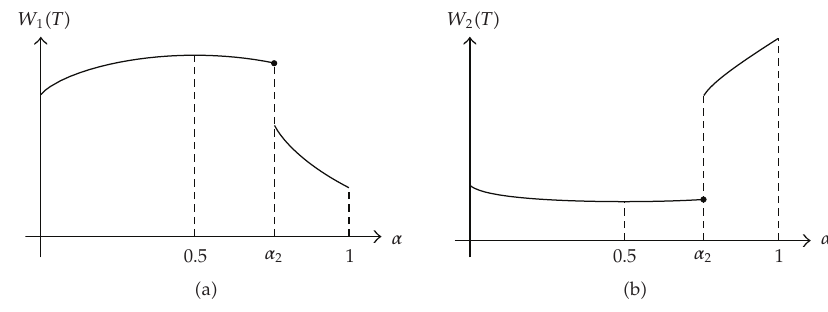
Figure 3: Case (cid:4) B (cid:7) : behaviour of W 1 and W 2 for T su ffi ciently big.